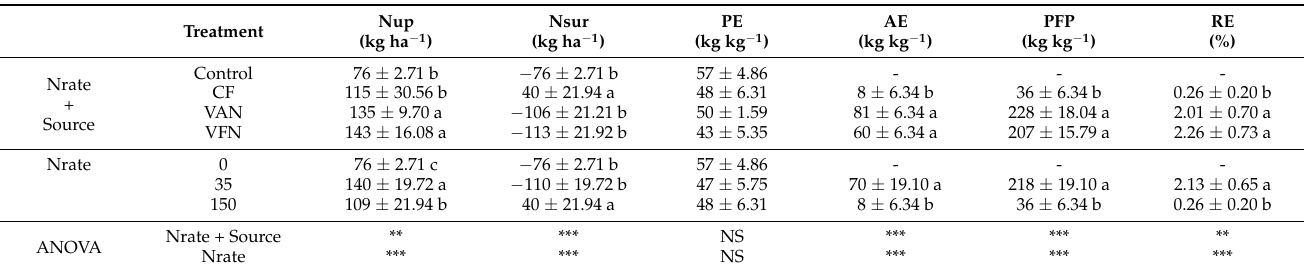
Table 3. Effect of Treatments (Nrate + Source) and Nrate on crop N uptake (Nup), N surplus (Nsur), Physiological Efficiency (PE), Agronomic Efficiency (AE), partial factor productivity of applied nutrient (PFP), Recovery Efficiency